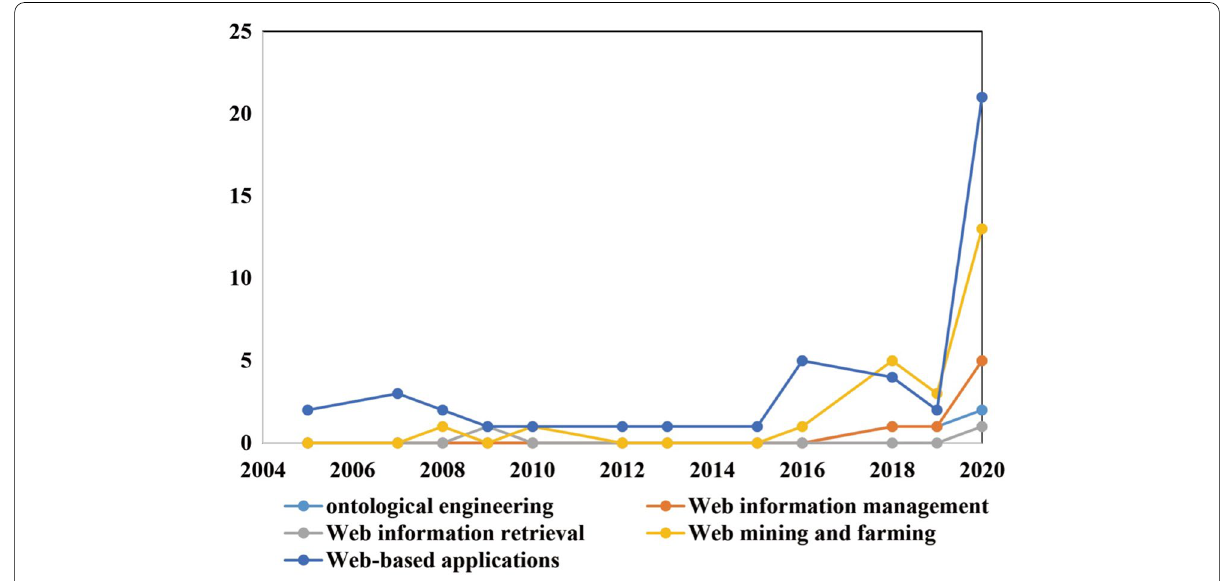
Fig. 13 Distribution of scopes of Web intelligence by